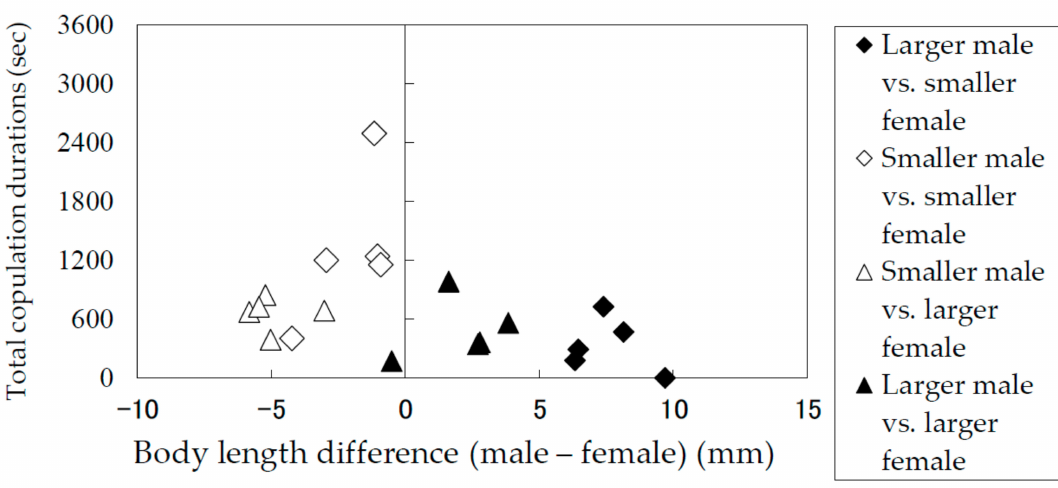
Figure 6. Total copulation durations of Rosalia batesi adult pairs with different body lengths (male body length—female body